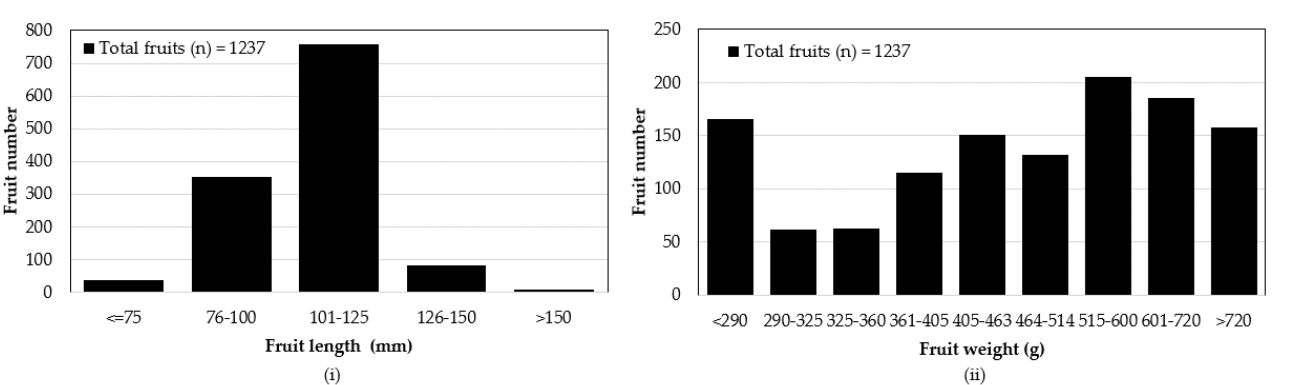
Figure 12. Frequency distribution of ( i ) fruit length and ( ii ) fruit weight, based on fruit lineal dimensions estimated from Honey Gold orchard row imaged at 5 fps. Fruit weight categories match those of Australian fruit tray sizes. Fruit weight was calculated using estimated length and width.